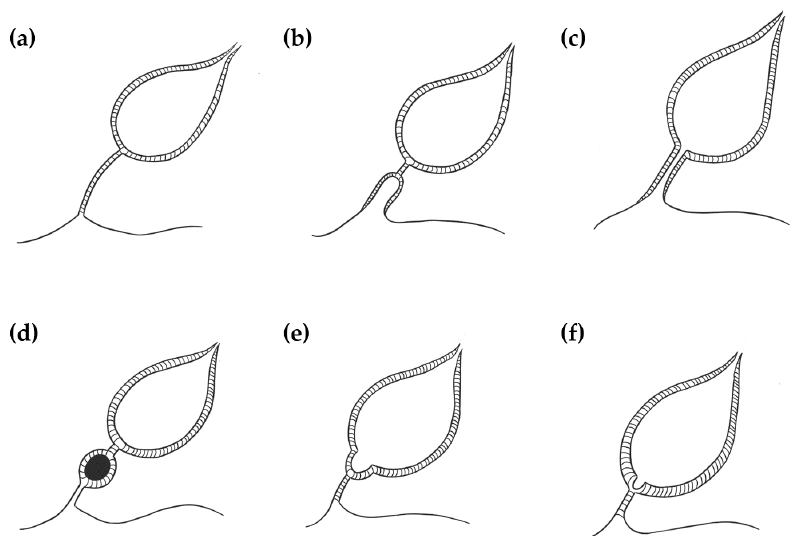
Figure 1. Illustration of the di ff erent types of urachal anomalies. ( a ) Normal bladder with a completely atrophied urachus; ( b ) urachal sinus: the distal part of the urachus remains patent and communicates with the umbilicus; ( c ) patent urachus: the urachal canal remains patent and connects the bladder to the umbilicus; ( d ) urachal cyst: a focal segment of the patent urachus remains persistent; ( e ) vesicourachal diverticulum (extramural): the portion of the urachus located at the bladder vertex fails to close, resulting in a blind diverticulum protruding beyond the serosal surface of the bladder; ( f ) vesicourachal diverticulum (intramural): in this case the blind diverticulum is limited to the thickness of the bladder wall.